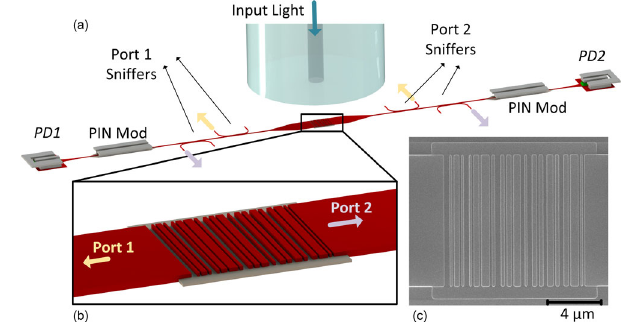
Fig. 4 Wavelength demultiplexer design and structures used for characterization. a On-chip structures used to measure and characterize the wavelength demultiplexer. The coupled power from the wavelength demultiplexer device at both output ports is measured simultaneously by using two photodiodes (PD1 and PD2). Positive-intrinsic-negative (PIN) modulator devices are displayed next to PD1 and PD2. Directional couplers act as sniffers to measure the coupled power at both wavelengths. b Wavelength Demultiplexing structure rendering (Port 1: 1310 nm, Port 2: 1550 nm). c Scanning electron microscope (SEM) image of the fabricated wavelength demultiplexer